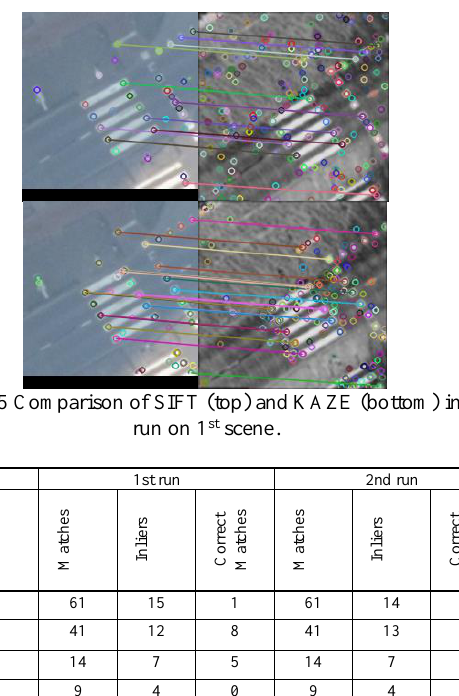
Table 6 Matching results of scene 1 between aerial and MLS ortho-image of the 1 st and 2 nd iteration